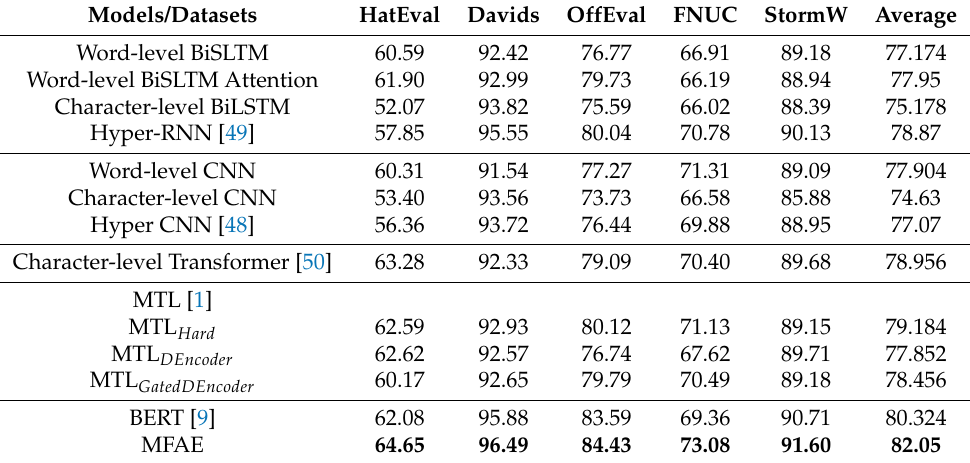
Table 3. Weighted F1 score (%) for different models on five datasets. The optimal results are indicated in bold. The table lists the character-level methods, word-level methods, MTL, BERT, and our models, respectively, and the results show that our model (MFAE) achieves the best